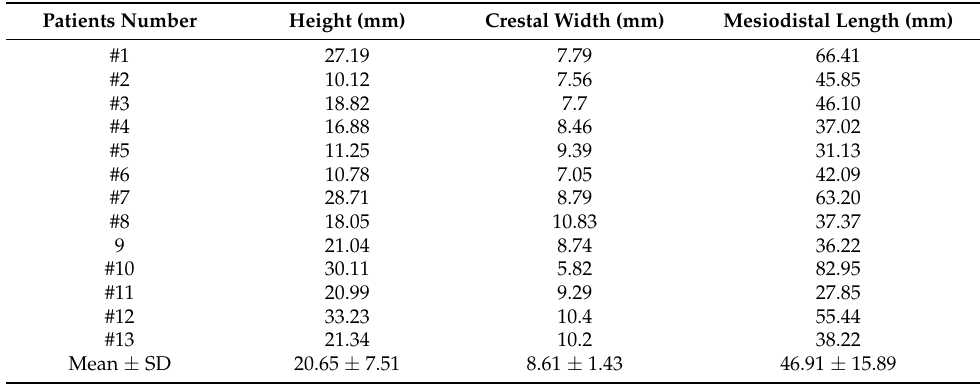
Table 5. Height, crestal width, mesiodistal length of the grafted bone